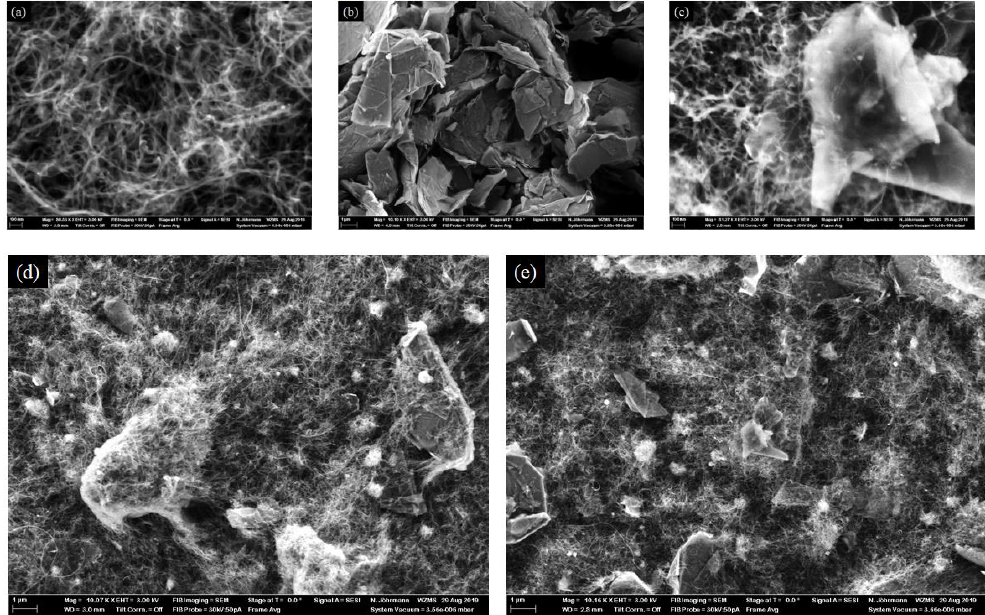
Figure 5. SEM images of the thin films, ( a ) MWCNTs in THF, ( b ) graphene in THF, ( c ) MWCNT-graphene in H-70:30; ( d ) and ( e ) homogeneity comparison of the water and THF-based hybrids.